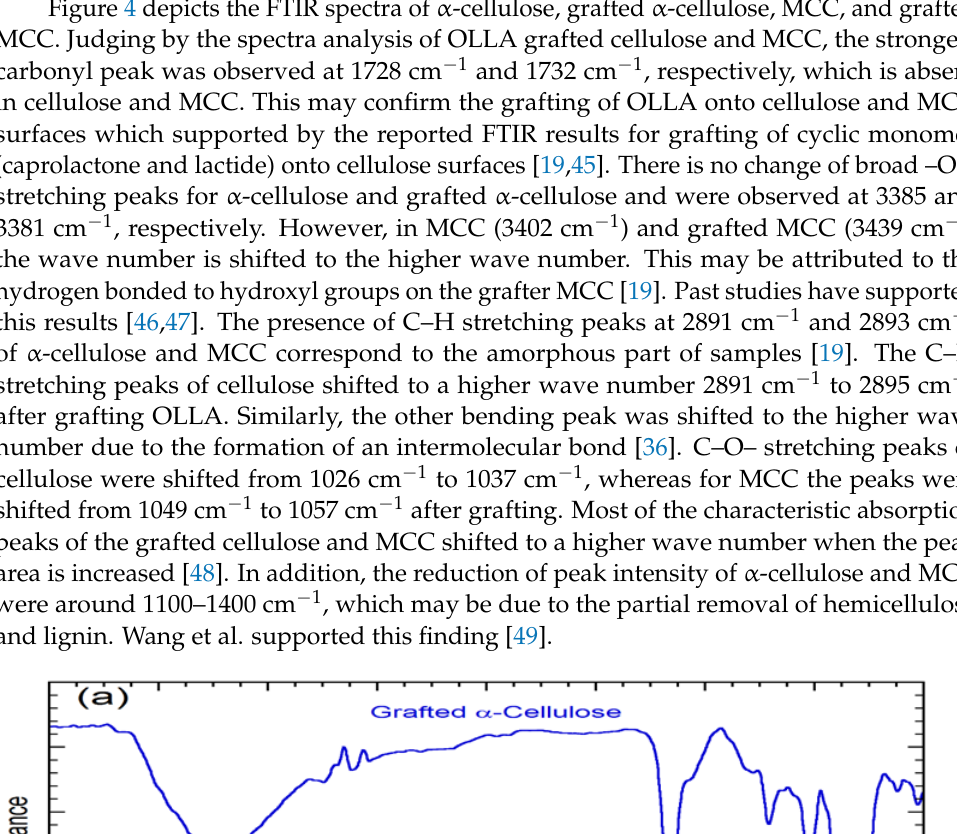
Figure 4. FTIR Spectra of α -cellulose and grafted α -cellulose ( a ), and MCC and grafted MCC ( b ). 3.4. SEM Analysis SEM photographs of non-grafted and grafted α -cellulose and MCC are shown in Fig- ure 5. Grafting of OLLA on to α -cellulose and MCC can be observed in Figure 5(a – d), respectively. Grafted surfaces of α -cellulose and MCC are different from non-grafted sur- faces, which confirms the grafting of OLLA and is consistent with the FTIR results [50]. Surfaces of the grafted MCC are more interesting (i.e., surface grafted area is higher when they are compared to the grafted α -cellulose).